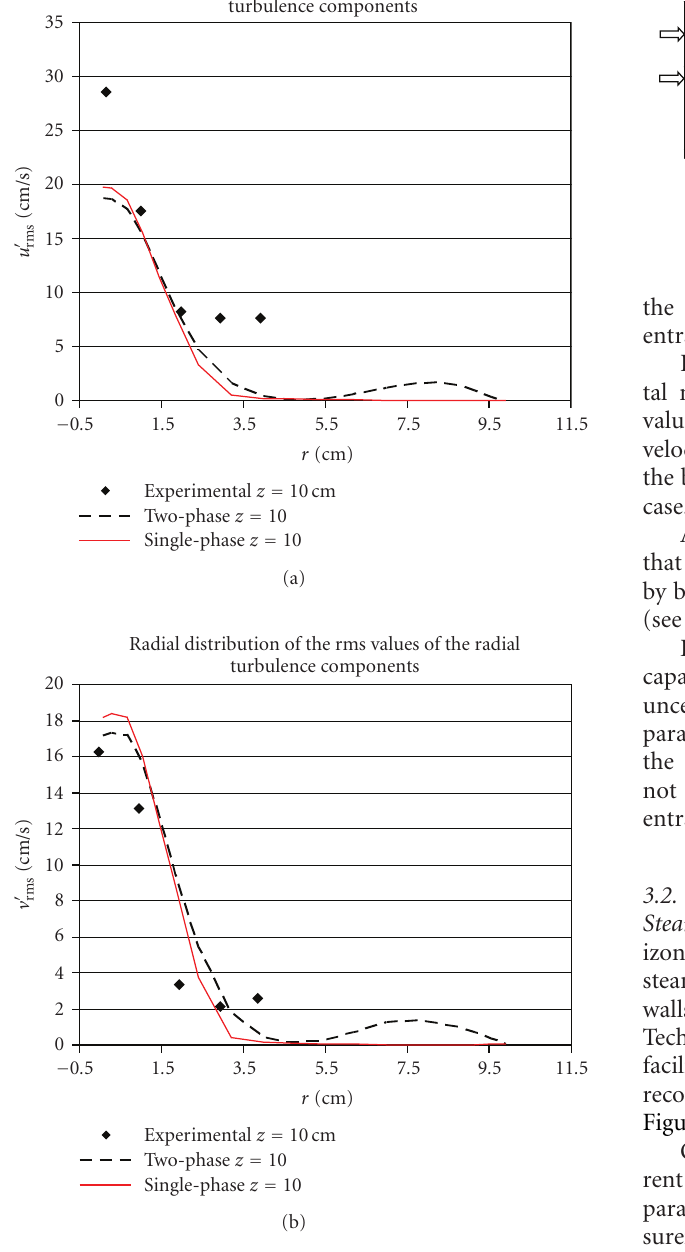
Figure 6: Radial distribution of rms values of the turbulence components-comparison between single- and two-phase results.